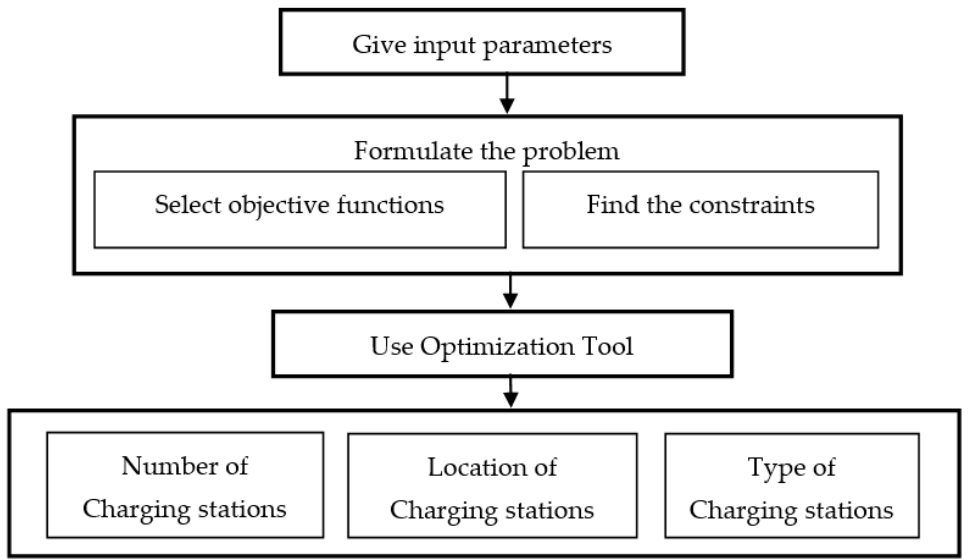
Figure 1. Steps of charging station placement solution.